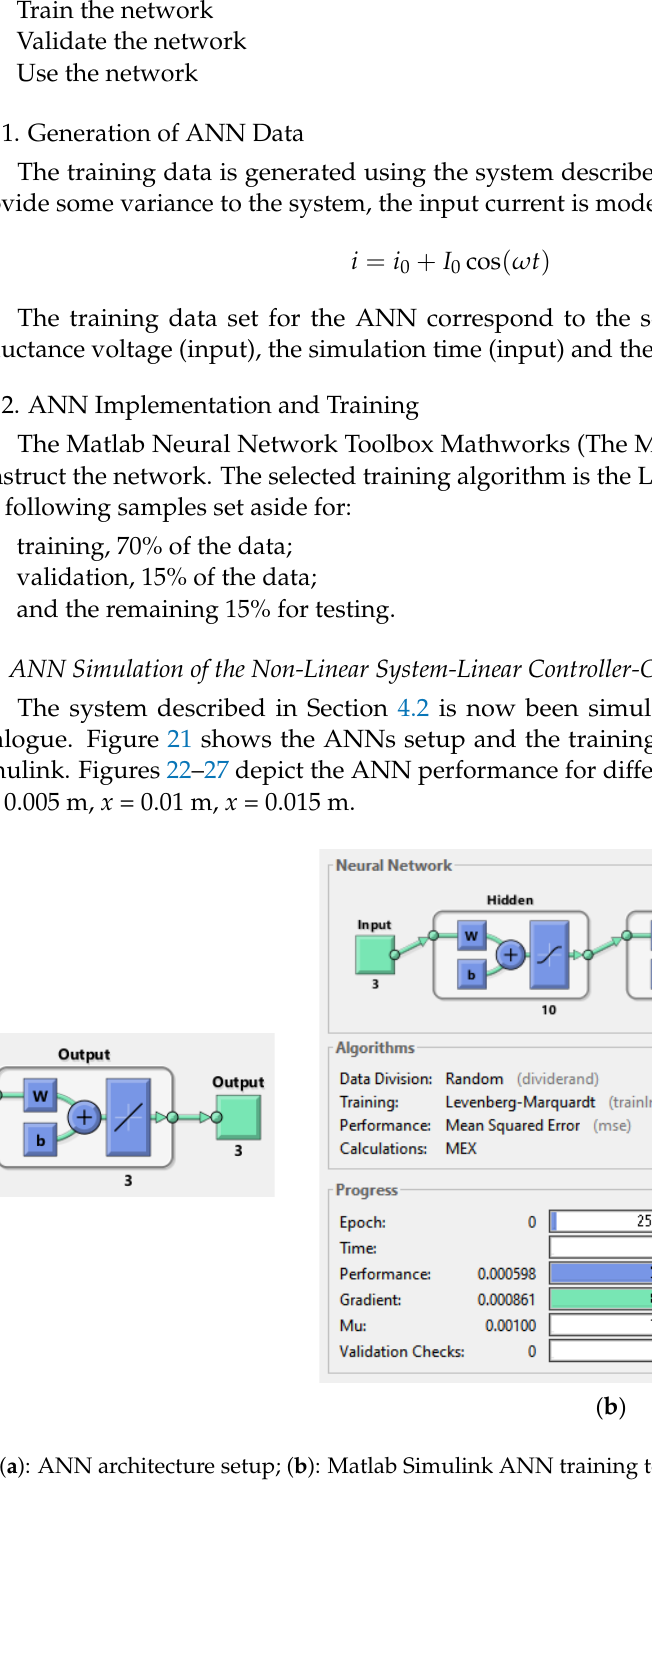
Figure 22. ANN regression plot, equilibrium at x = 0.005 m.